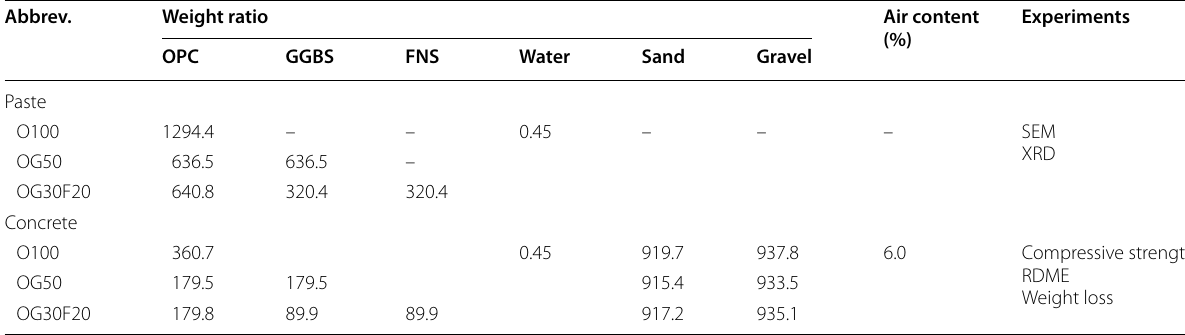
Table 3 Mix proportions for experimental works (kg/m 3 ).